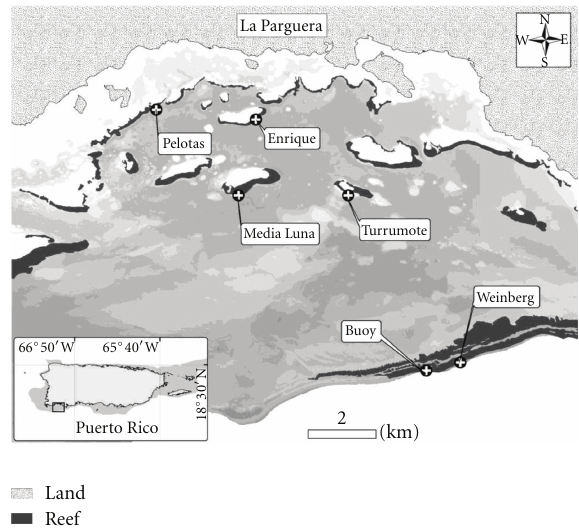
Figure 1: Map of the study sites in La Parguera, Puerto Rico.